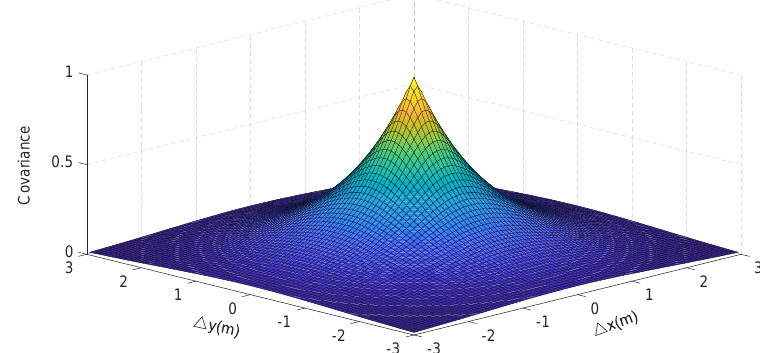
Figure 10. The relationship between the distance and the covariance of different